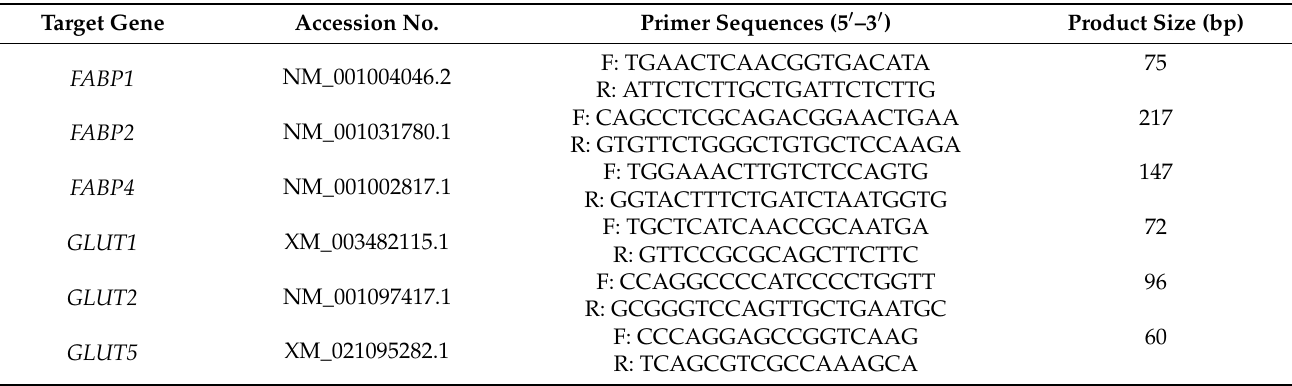
Table 2. Primer sequences of the target